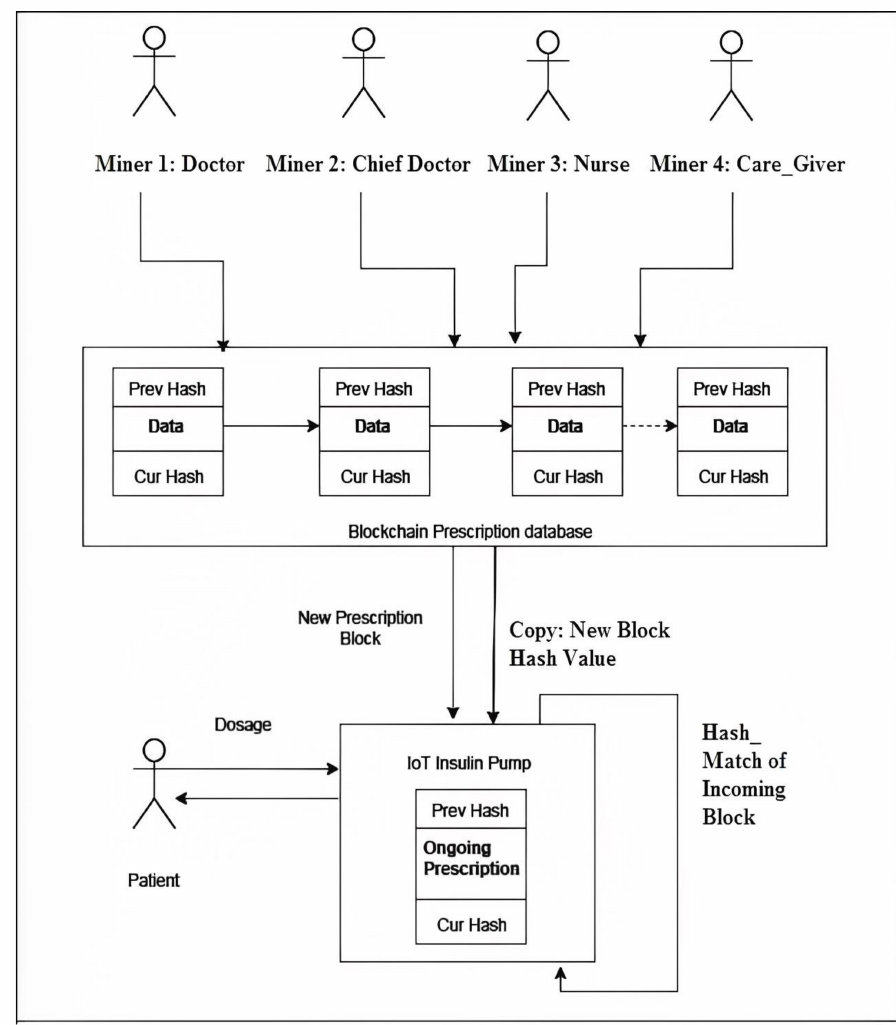
Figure 1. Block Diagram of a Blockchain-based IoT insulin pump